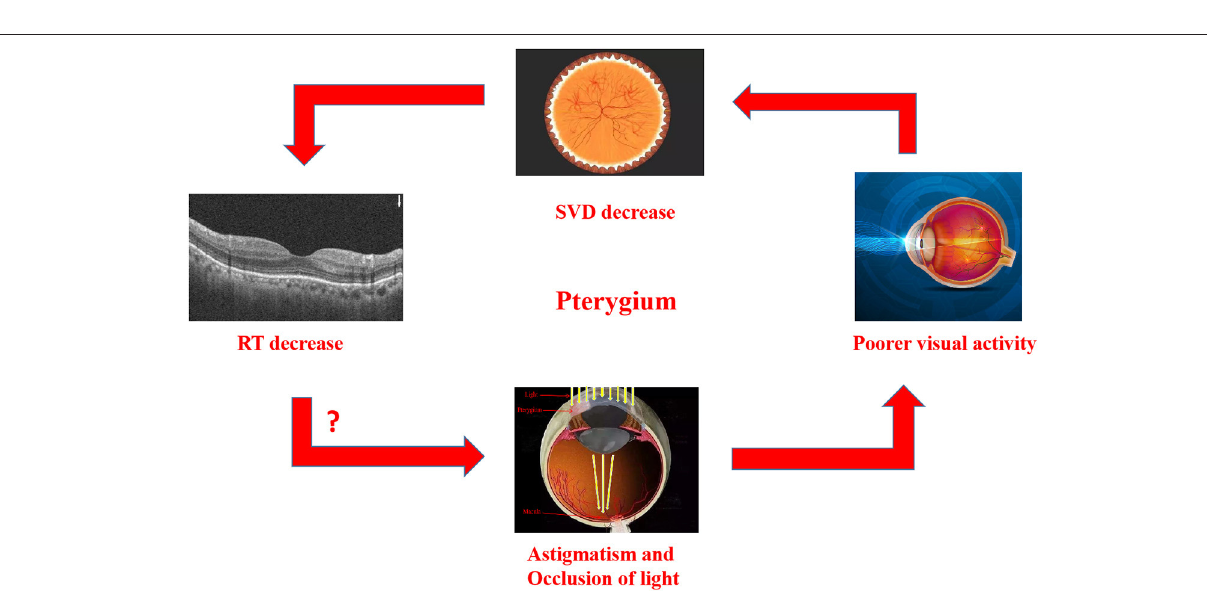
FIGURE 6 | Relationship between RT thinning in patients with Pterygium, and there is also a correlation between RT thinning and visual impairment. In Pterygium group, astigmatism and occlusion of light may lead to the decrease of vision., SVD in macular and RT in related areas. The macular area is marked on the image of eyeball, which reveals the decrease of SVD and RT in this area. RT, retinal thickness; SVD, superficial vessel